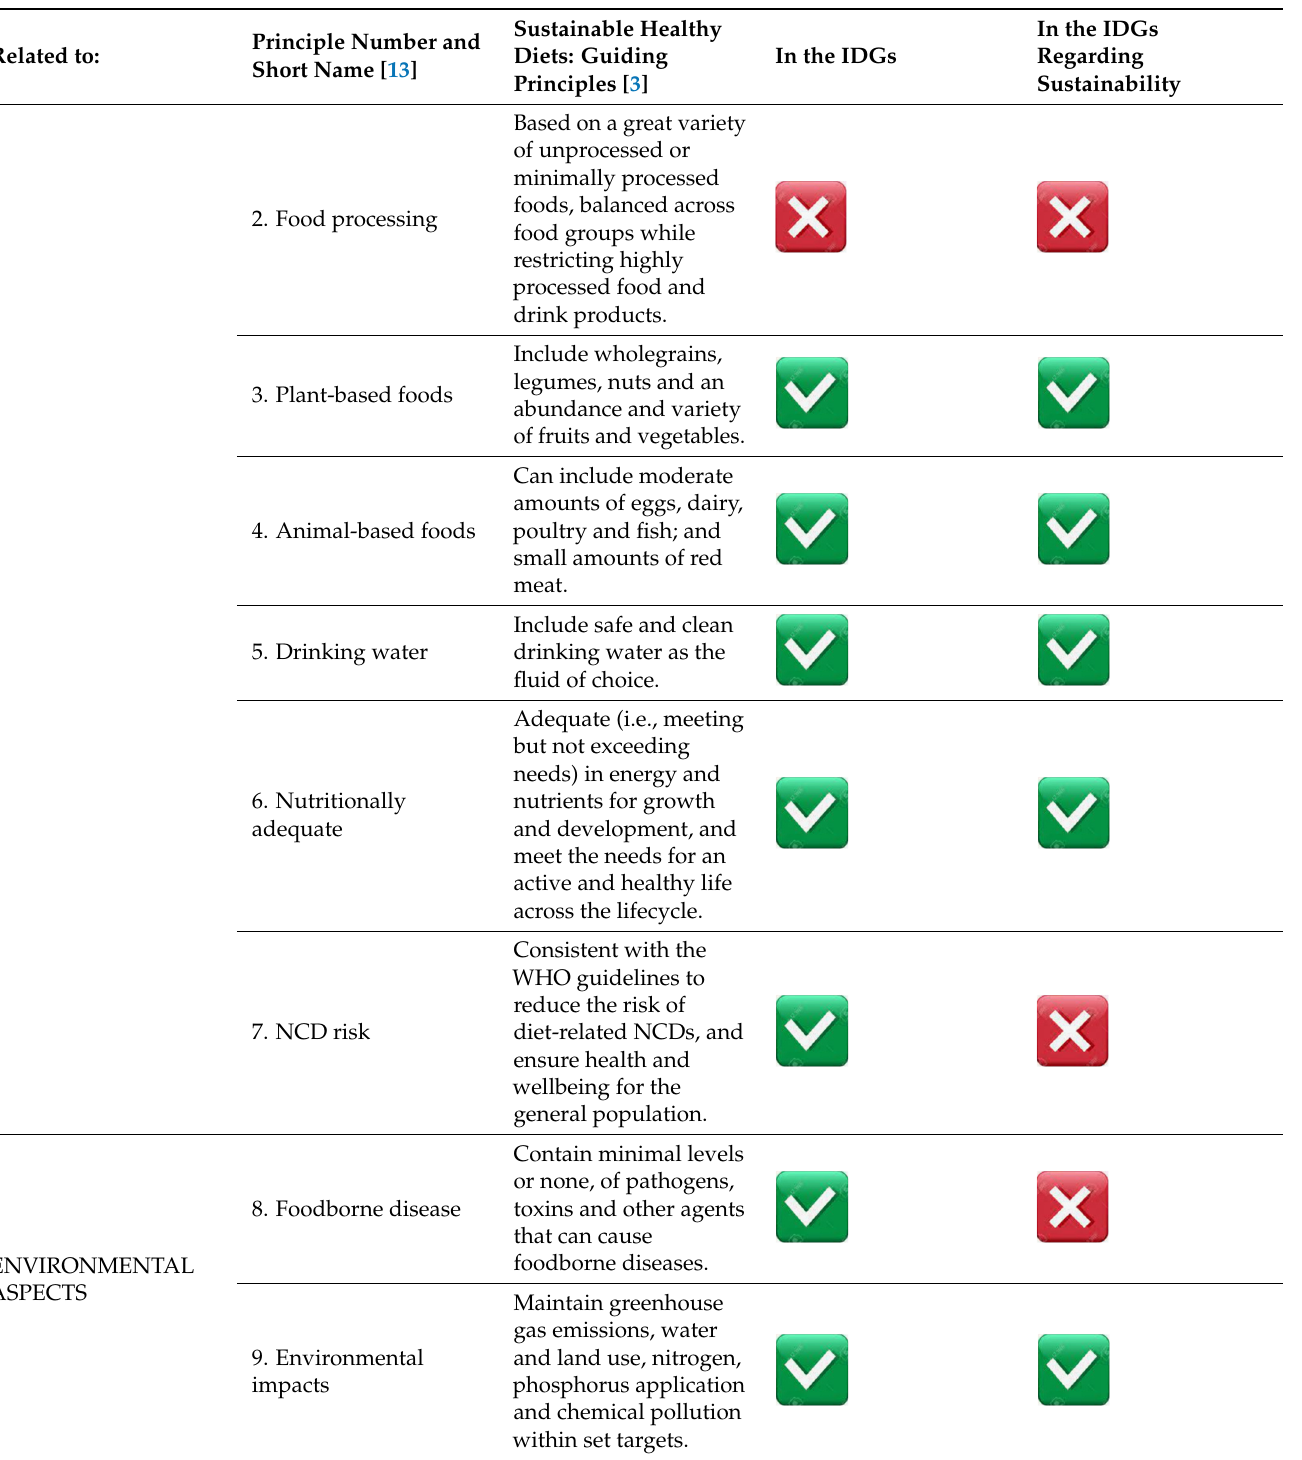
Table 1. The 16 guiding principles of a sustainable healthy diet in the IDGs regarding sustainability. Key to symbols: